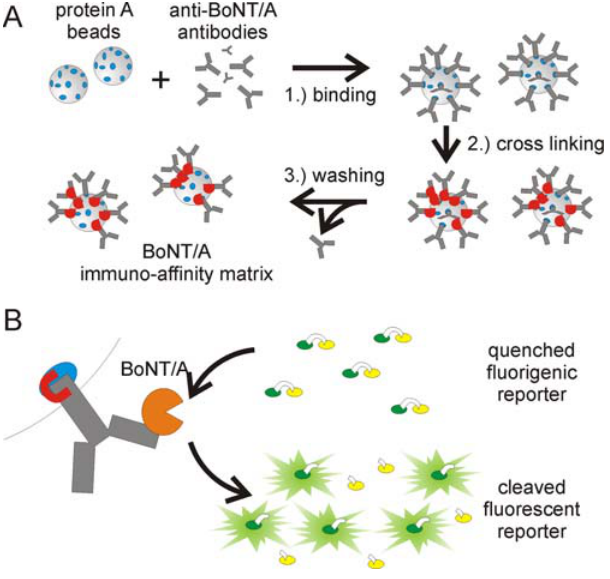
Figure 1. The ALISSA principle. (A) Synthesis scheme for the immuno-affinity matrix for BoNT-enrichment. Protein A-agarose beads are coupled to affinity-purified anti-BoNT antibodies. Disuccinimidyl suberate (DSS) is used to crosslink the FC domain of the antibodies to protein A. Non-crosslinked antibodies are removed by stringent washing. (B) Immobilized BoNT/A cleaves a quenched FRET pair, provided in form of a fluorogenic peptide substrate, thereby releasing the fluorophore from the quencher, which restores